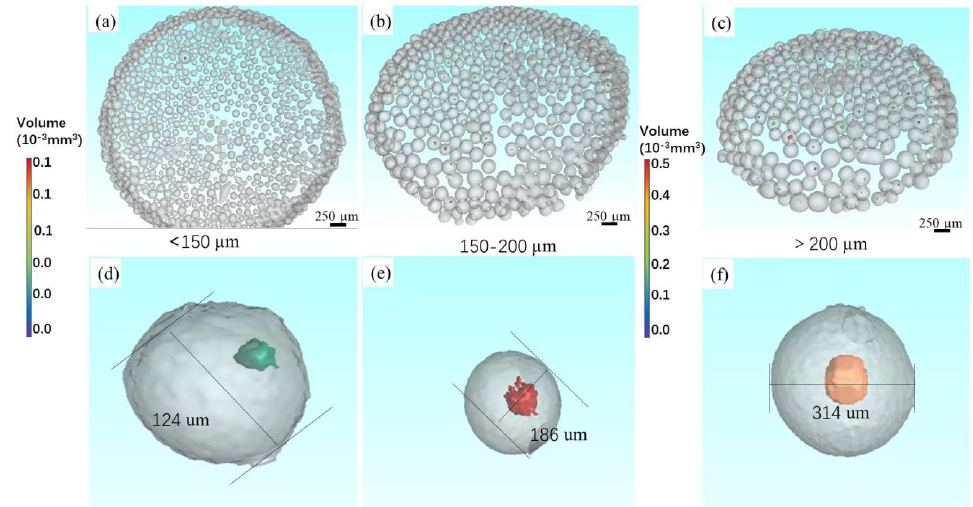
Figure 8. The 3D reconstructed CT of Ti-6Al-4V powders at 8000 RPM with different size ranges. ( a ) <150 µm, ( b ) 150–200 µm, ( c ) >200 µm and the typical pore morphology for particle in the particle range of ( d ) <150 µm, ( e ) 150–200 µm and ( f ) >200 µm.